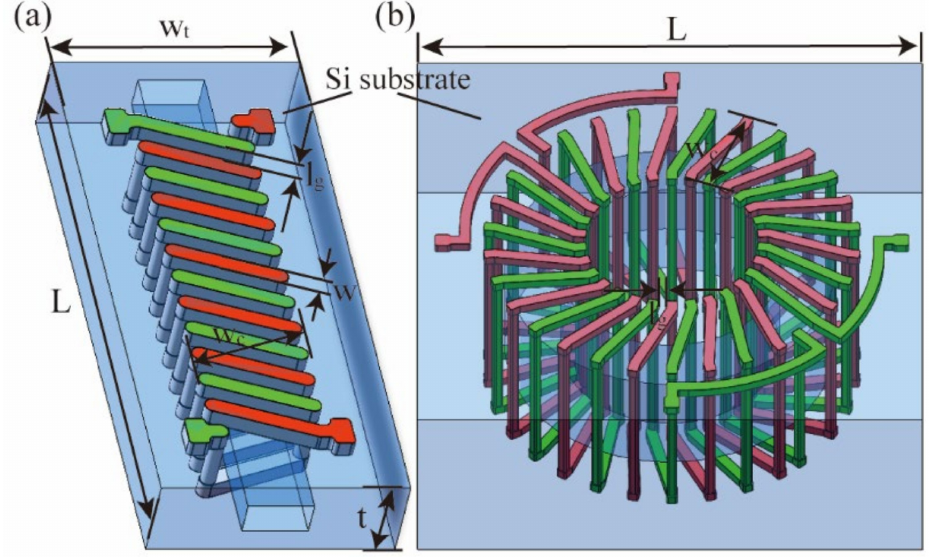
Figure 1. Models of the two transformer types. ( a ) Solenoidal and ( b ) toroidal. Under the same parameters, the area of the toroidal transformer was larger than that of the solenoidal